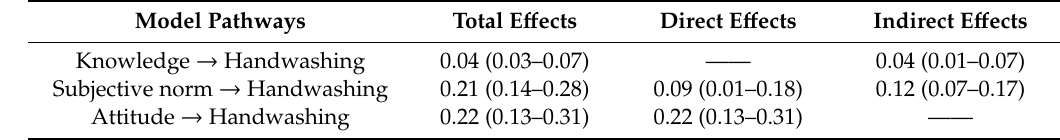
Figure 2. Standardized path coe ffi cients and the relationships of the variables. Note: Values indicate standardized coe ffi cients; * p < 0.05, ** p < 0.01, *** p < 0.001. Table 3. Results of the structural equation